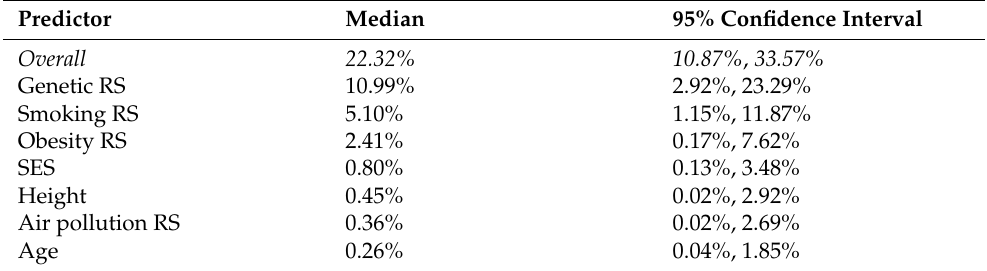
Table 3. Relative Contributions (bootstrap median and 95% percentile confidence interval) of the predictors for FEV 1 , as percentages, sorted according to the median. Predictor Median 95% Confidence Interval